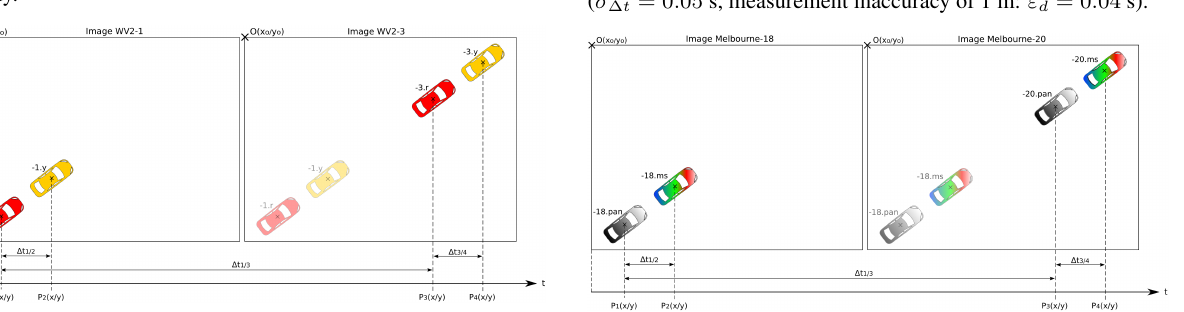
Figure 13: Time calibration for Pl´eiades stereo imagery; left: a car with positions in pan and a multispectral channel of the first stereo image; right: the same car in the second stereo